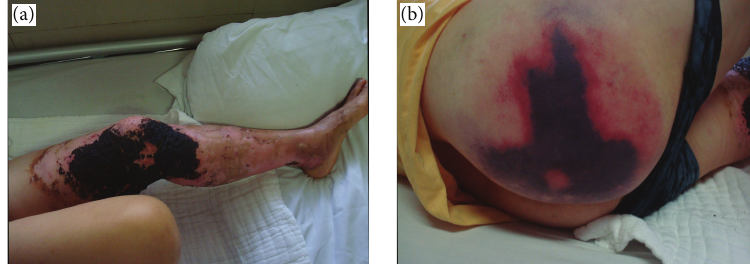
Figure 1: Photograph of the patient when admitted to the department. (a) Alcohol flame burn covered by traditional Chinese medicine. (b) Painful erythema on the right buttocks.